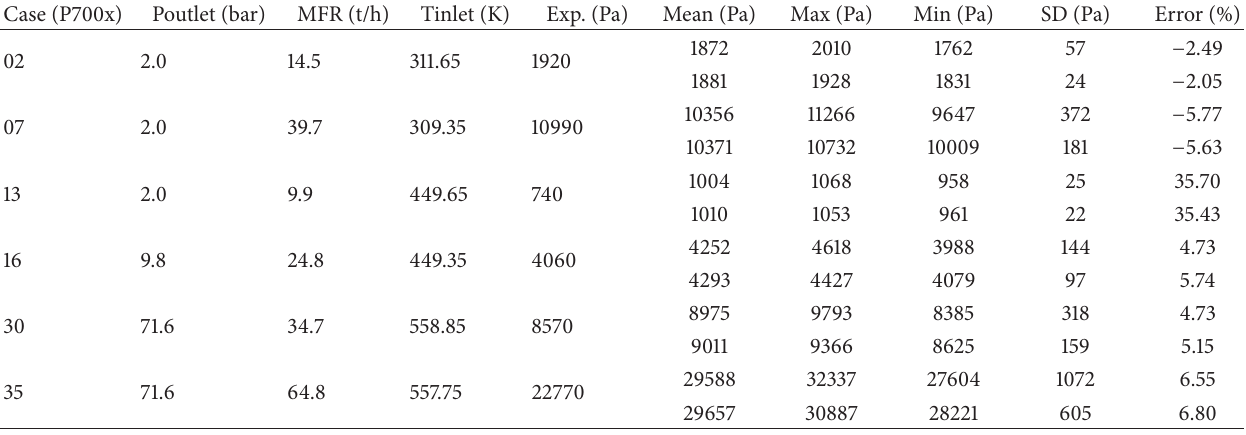
Table 3: Input parameter combinations and uncertainty results for the single-phase flow pressure drop cases.